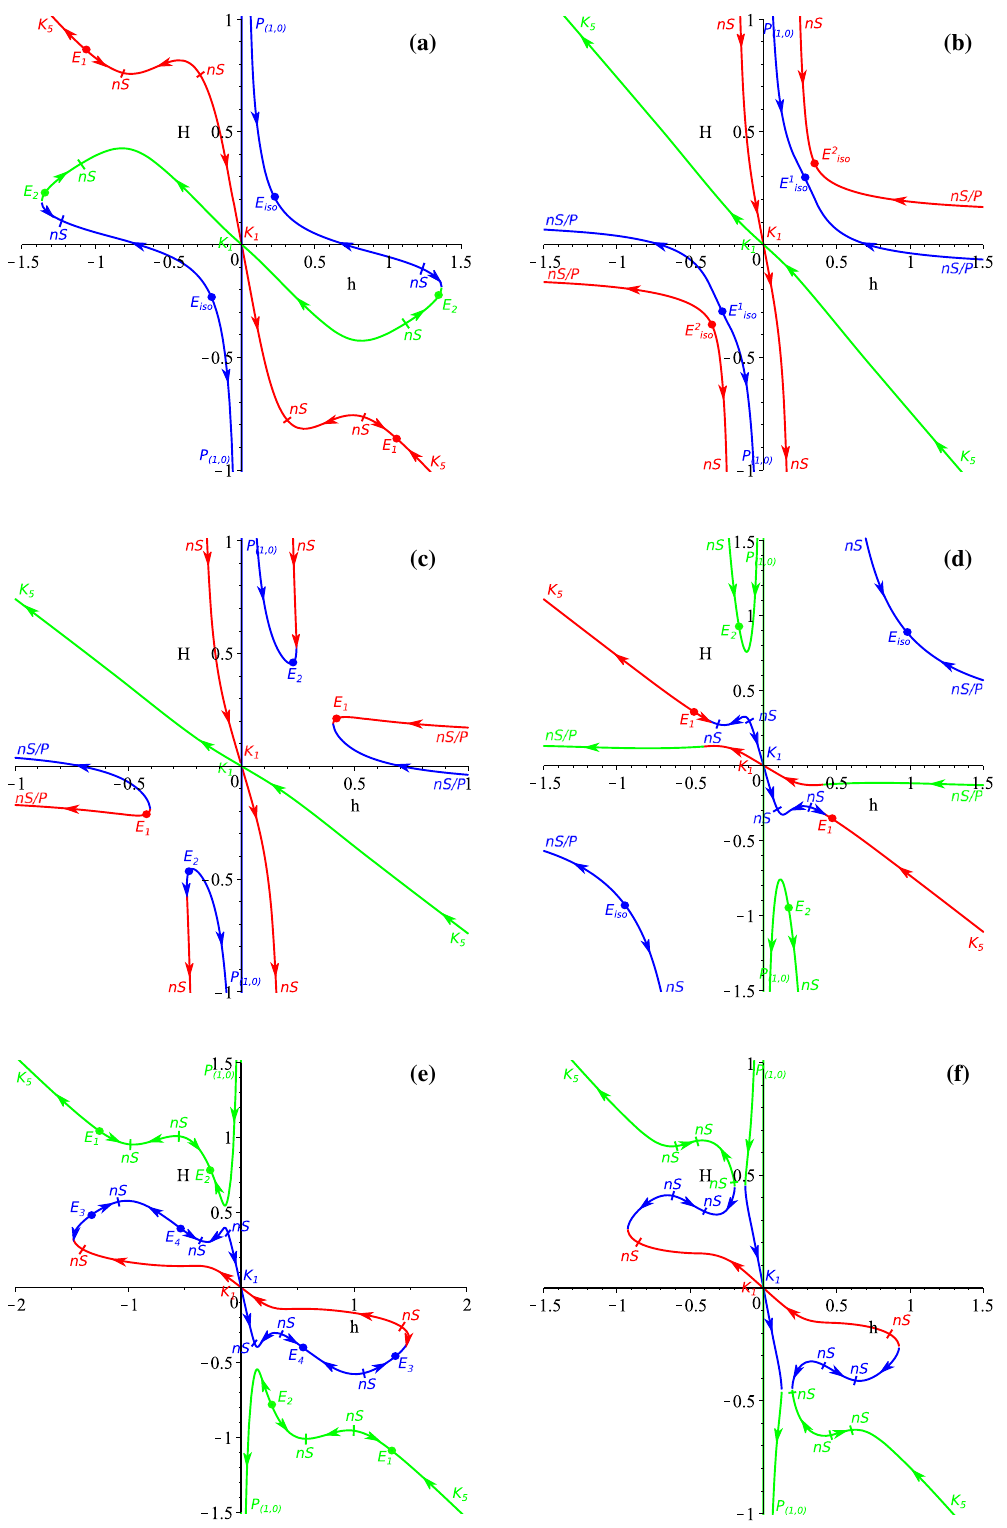
Fig. 9 Final compilations of all possible regimes in D = 4 vacuum cubic Lovelock case, on H ( h ) evolution curves; different colors corre- spond to three different branches H 1 , H 2 and H 3 ; panels layout is as follows: α < 0, β < 0 on a panel, α < 0, β > 0, μ < 5 / 6 on b